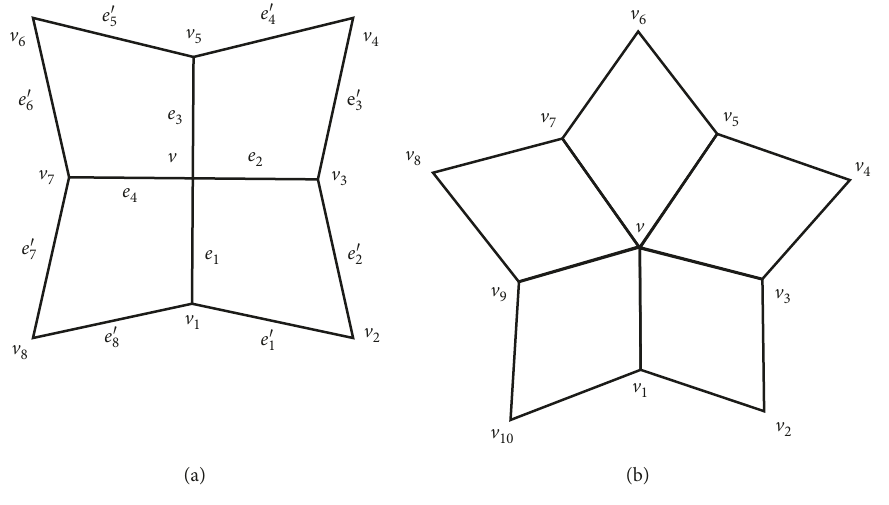
Figure 1: Jahangir graph ( J